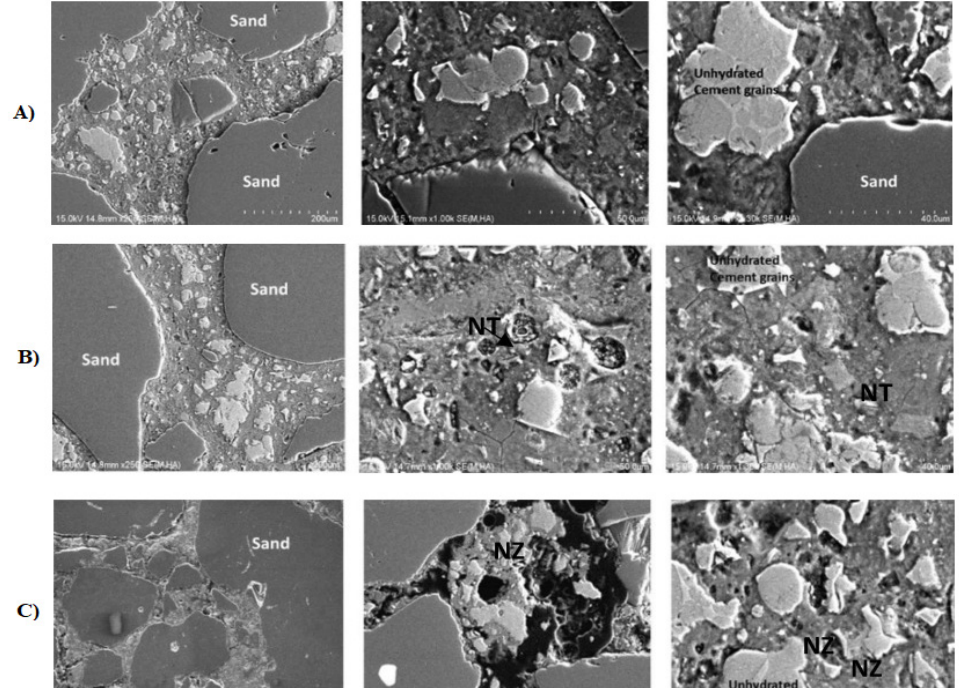
Figure 3. SEM photos of samples after 7 days of curing—( A ) control sample, ( B ) cement sample with 2% nano-TiO 2 , ( C ) cement sample with 2% nano-ZnO [105] (RightsLink for Elsevier).